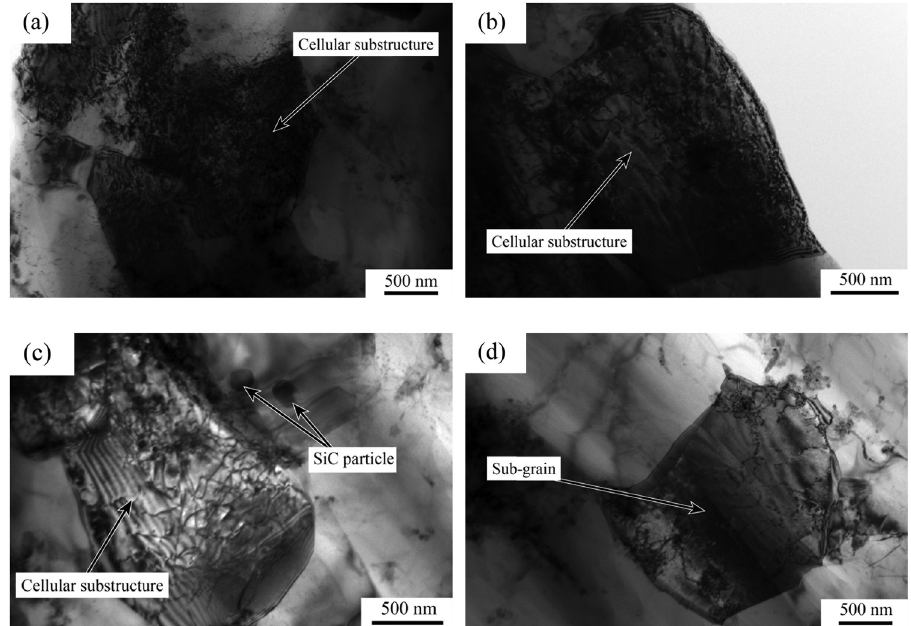
Figure 10: TEM images of nano - SiCp/Al – 7Si matrix composites at di ff erent deformation conditions: ( a ) T = 470°C, ε ̇ = 5 s − 1 ; ( b ) T = 470°C, ε ̇ = 1 s − 1 ; ( c ) T = 490°C, ε ̇ = 5 s − 1 ; and ( d ) T = 490°C, ε ̇ = 1 s − 1